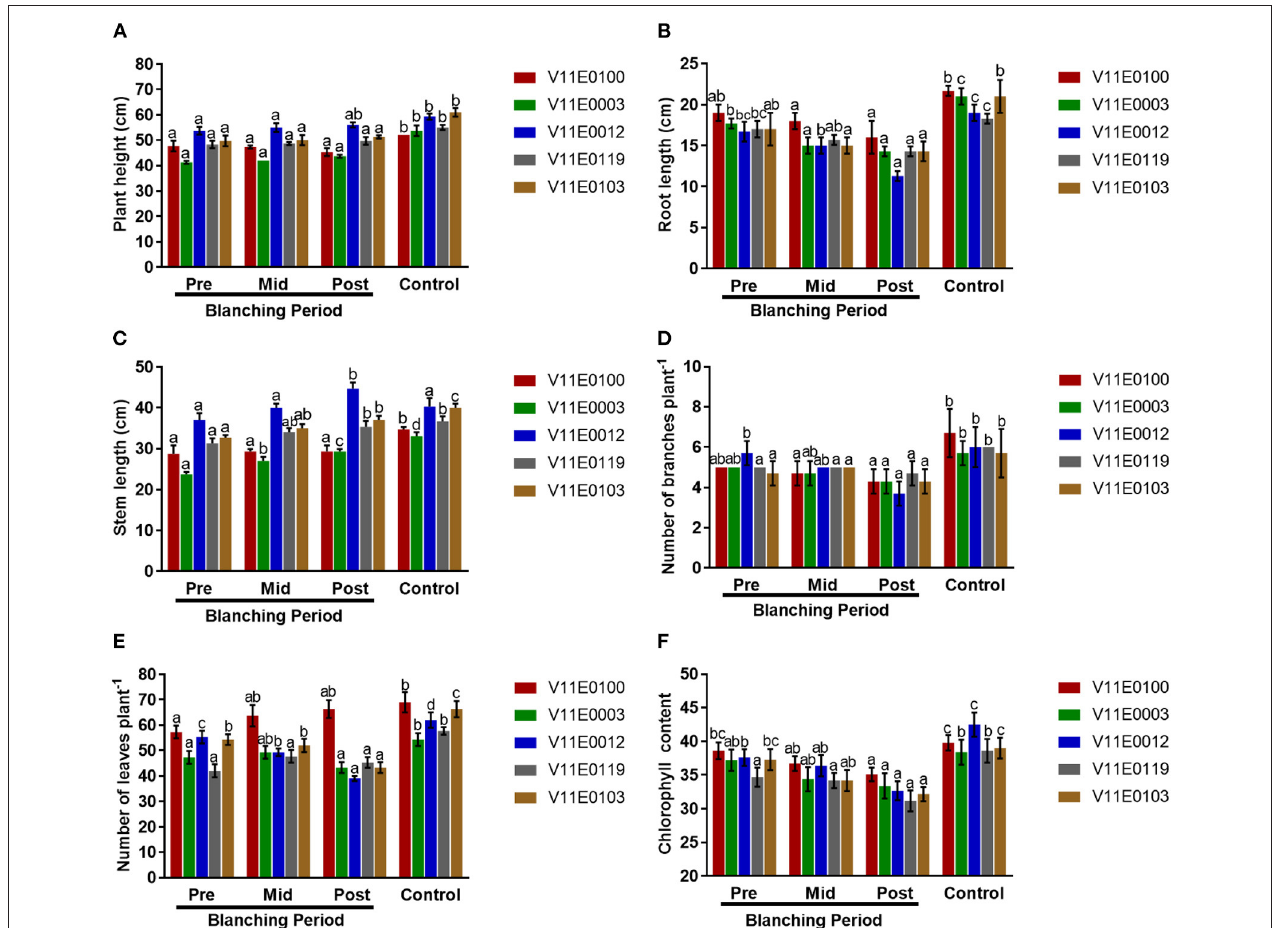
FIGURE 1 | Effect of blanching on the phenotype of five water dropwort cultivars. (A) Plant height, (B) root length, (C) Stem Length, (D) Number of branches, (E) Number of leaves, and (F) Chlorophyll content of leaves. Four types of samples were used for analysis; Pre-blanching, Mid-blanching (20 days), Post-blanching (40 days), and Control (grown under normal conditions). Different letters indicate a significant difference ( P < 0.05) among the treatments according to the Tukey test. Values are means ±